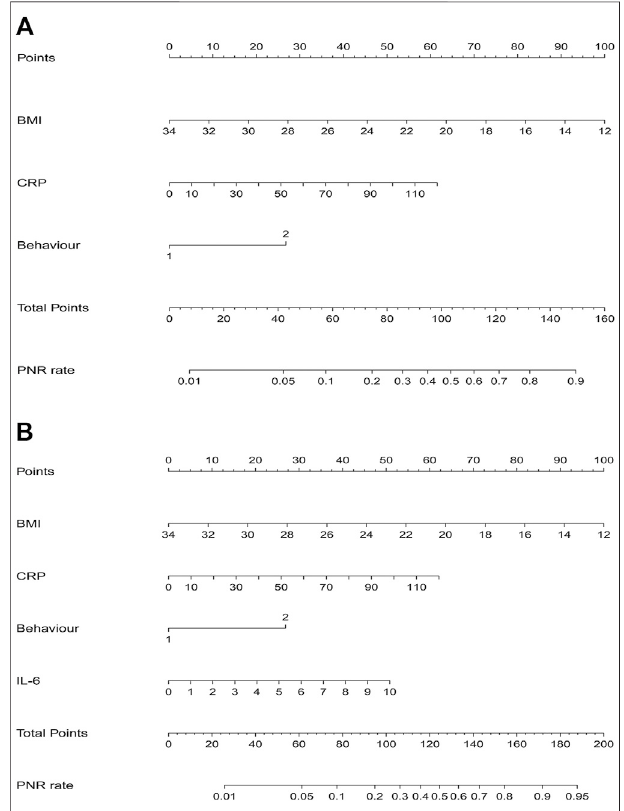
FIGURE2| Nomogramsformodel1andmodel2weredevelopedinthe training cohort (A) Nomogram one for model 1, with BMI, behavior, and CRP. BMI,BodyMassIndex; CRP,C-reactiveprotein (B) Nomogramtwoformodel 2, with BMI, behavior, CRP, and IL6. IL6,